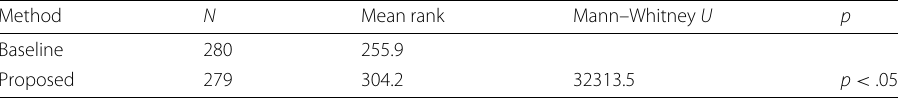
Table 2 The results of the Mann–Whitney test